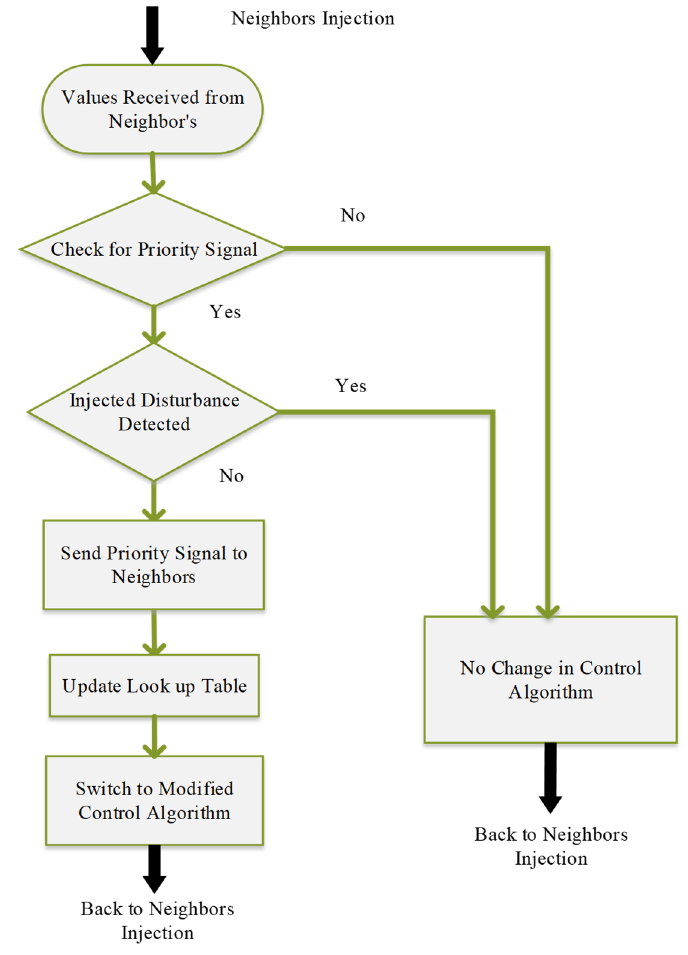
Figure 6. Flow Chart for the Proposed Islanding Detection Method.